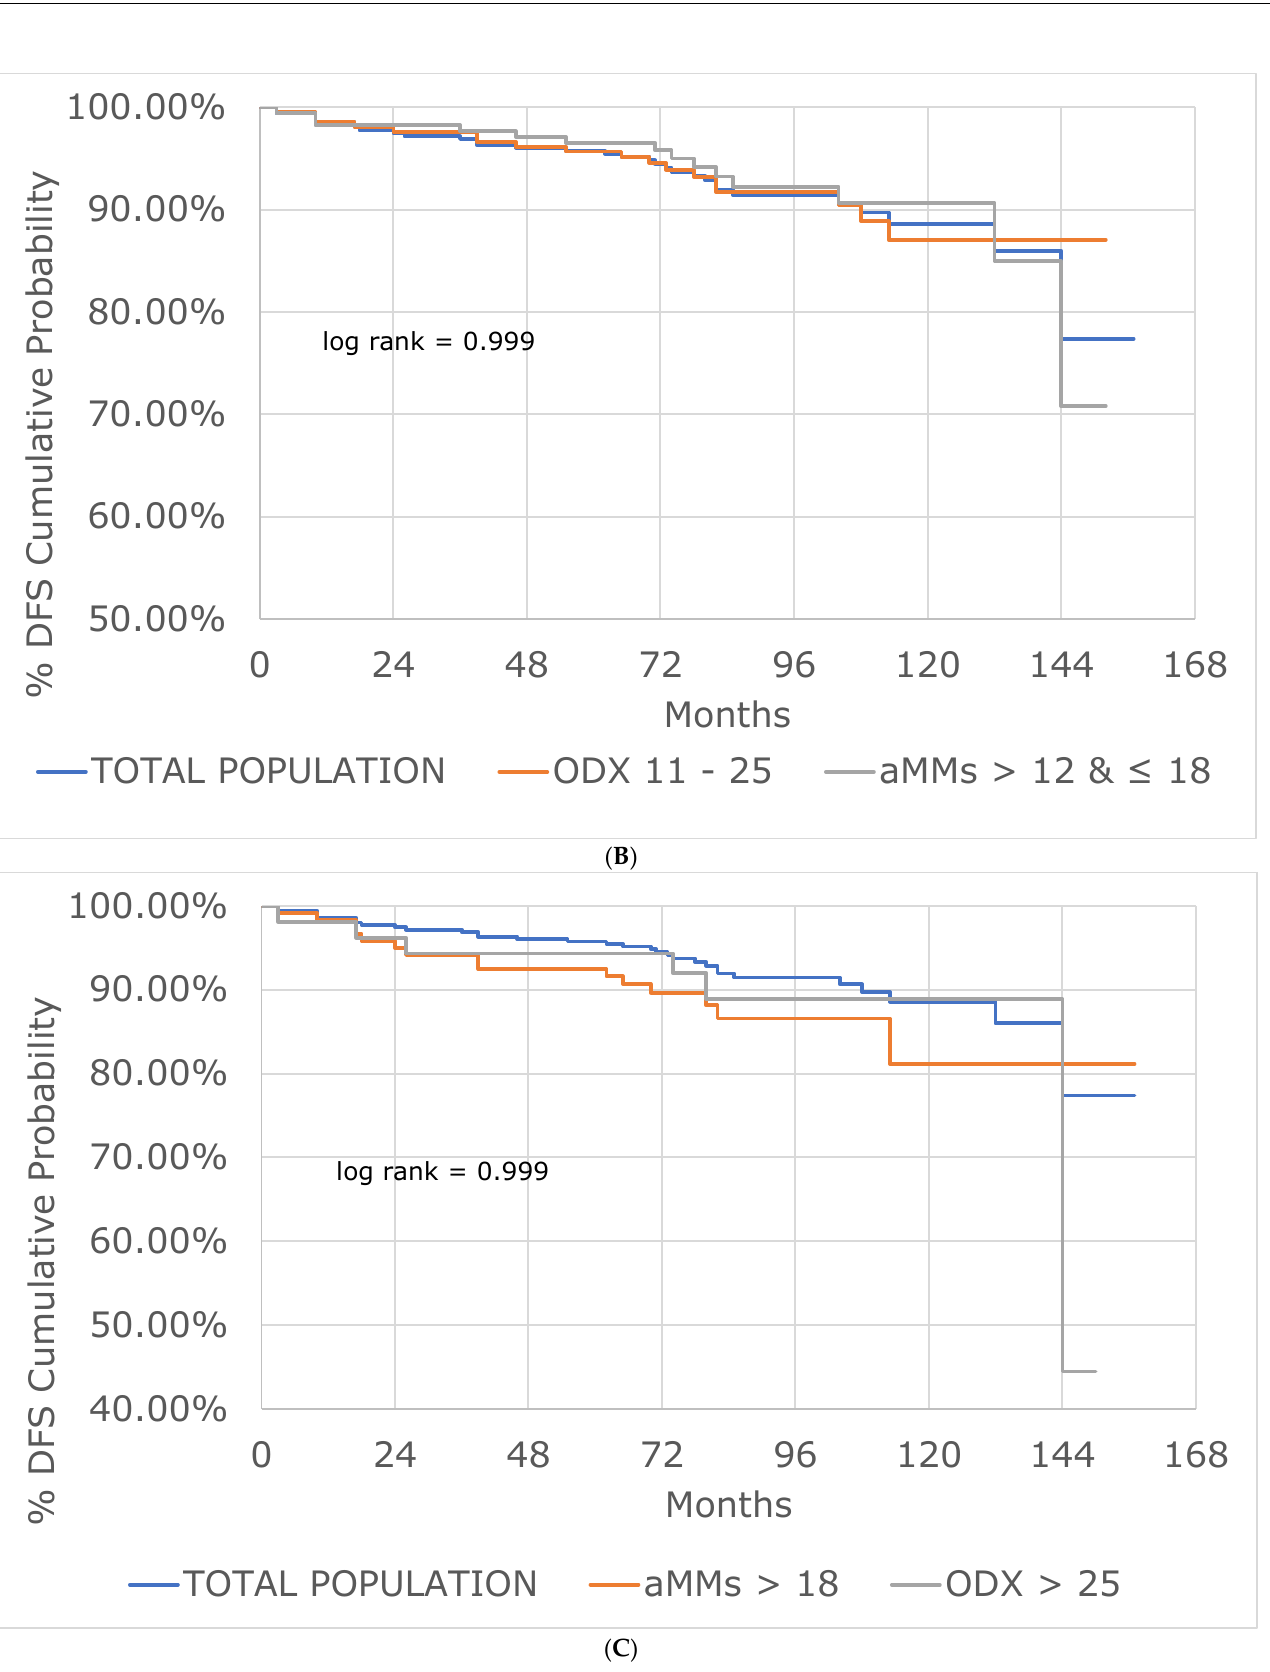
Figure 2. Kaplan – Meier curves, disease free survival (DFS) in the very low risk ( A ), low risk ( B ), and high risk ( C ) breast cancer populations. Abbreviations: aMMs = average Modified Magee score; ODX = Oncotype DX ® .